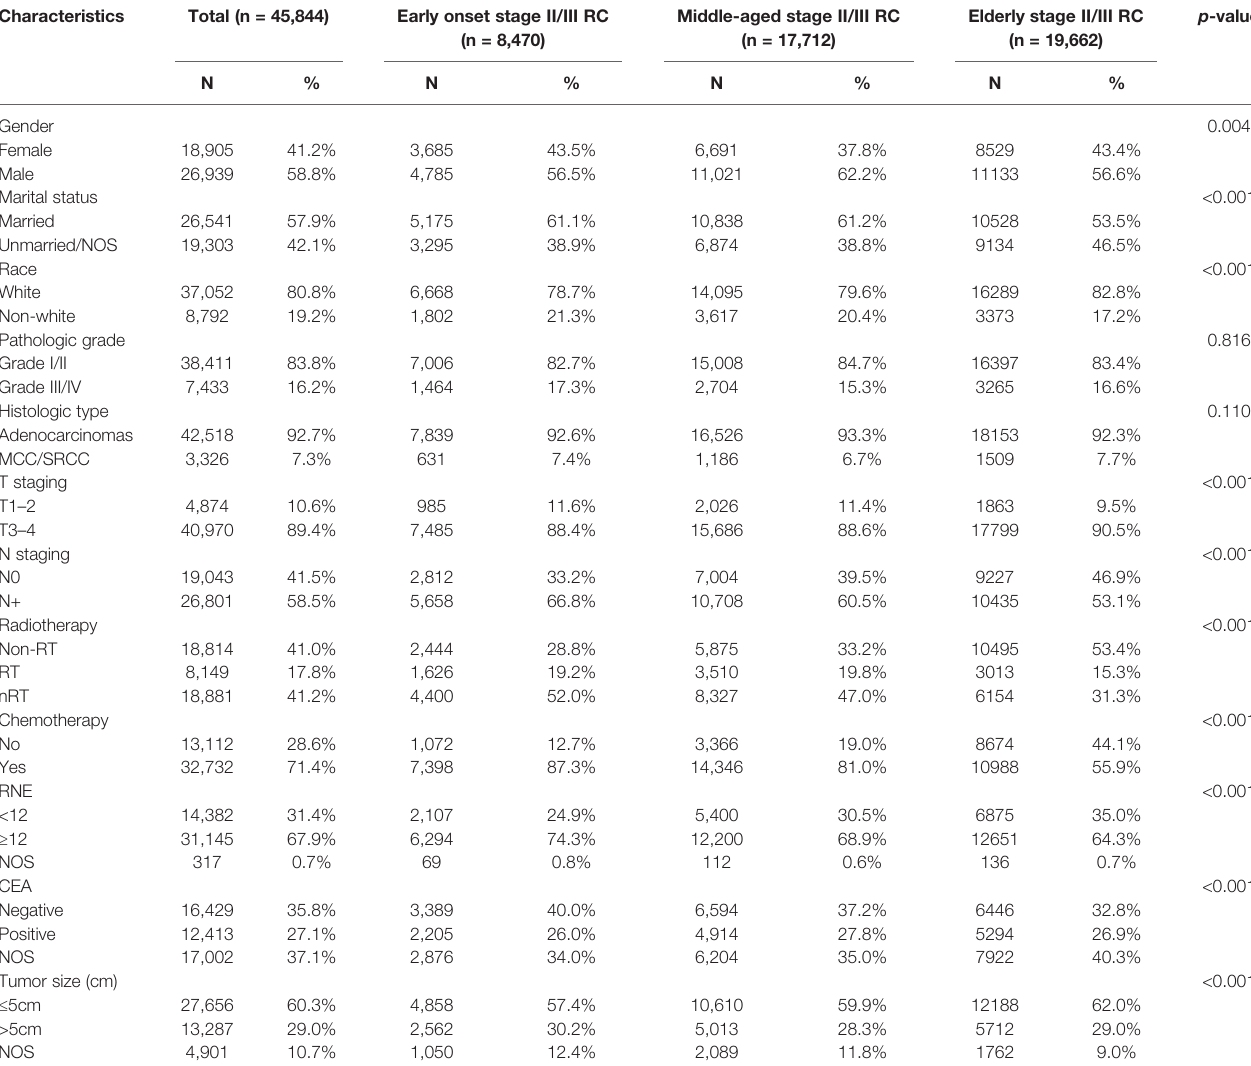
( Figure 5A ) illustrated that both RT and nRT failed to prolong OS of middle-aged patients with stage II/III RC, which was further con fi rmed by survival analysis after PSM ( Table S4; Figure 5B : RT vs . non-RT, p = 0.712; Figure 5C : nRT vs . non- RT, p = 0.584). Interestingly, nRT can be used as a prognostic